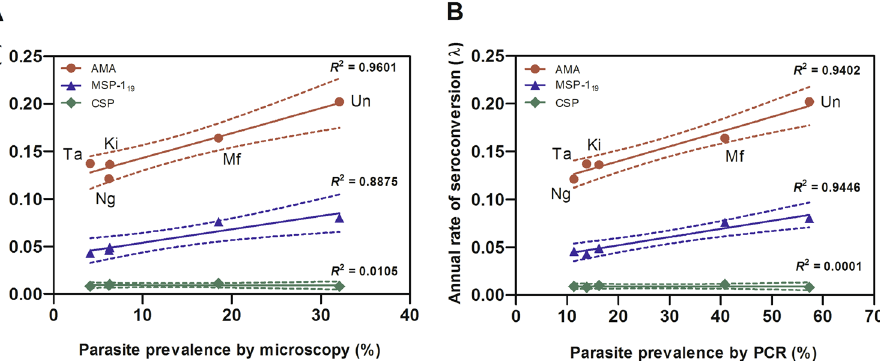
Figure 4. Association between the annual rate of seroconversion and P . falciparum parasite rate in the study area. Plot of estimate of seroconversion rates ( λ ) (calculated as for Table 2) against P . falciparum parasite rates by ( A ) microscopy, and ( B ) PCR. Un = Ungoye, Mf = Mfangano Island, Ta = Takawiri Island, Ki = Kibuogi Island, and Ng = Ngodhe